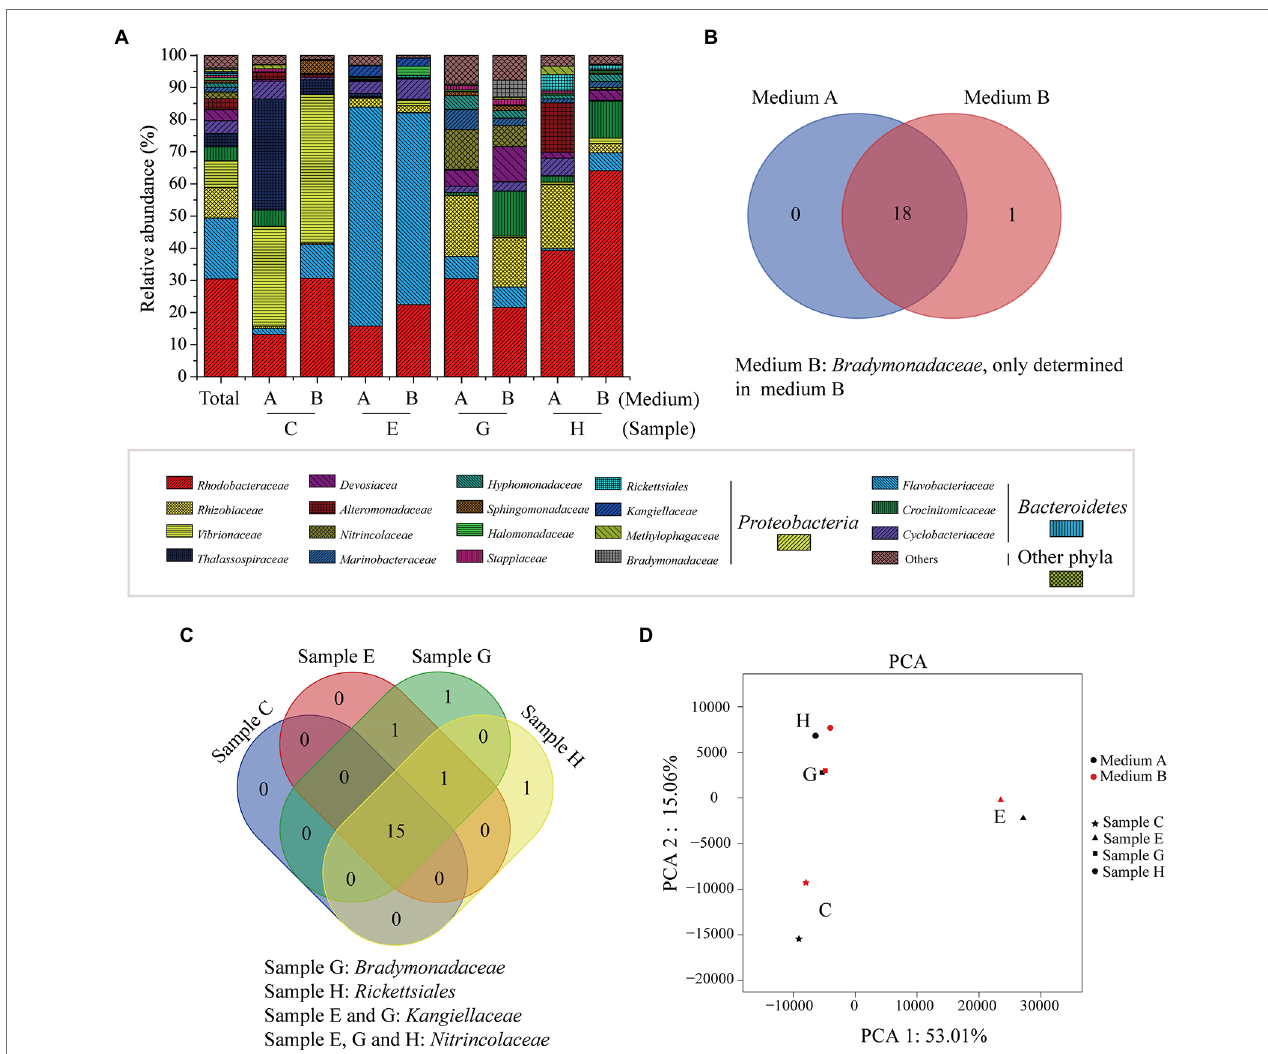
FIGURE 2 | The bacterial communities recovered from algal samples with 1,3-xylan based on 16S rRNA gene amplicon sequencing. (A) Relative abundance of recovered bacteria at the family level. (B) A venn diagram analysis of recovered families from algal samples. (C) A venn diagram analysis of recovered families from media A and B. (D) Principal component analysis (PCA) of the bacterial